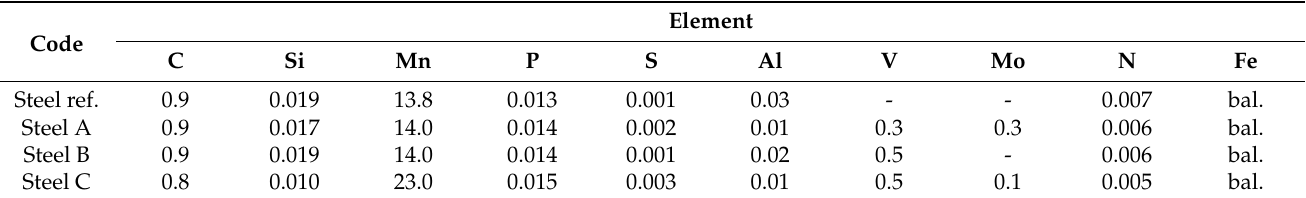
Table 1. Chemical composition (wt.%) of high-Mn steels for hot ductility test.